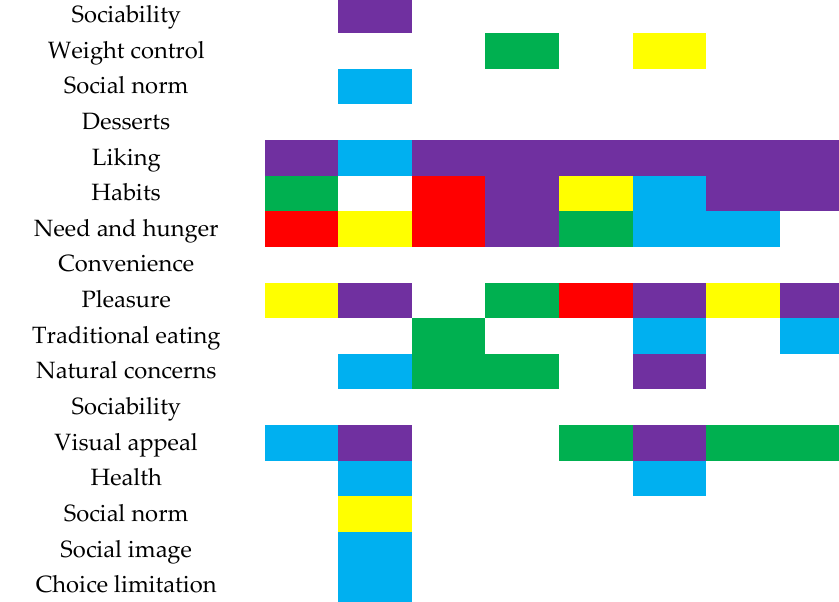
Figure 1. ( a ) Rank of the top five motivation constructs based on percentages of “apply” responses for RATA ( A ) and RATING ( C ) survey formats within each food group for Brazil, Spain, and the USA. Additionally, the top five motivation constructs based on mean scores per country for RATA ( B ) and RATING ( D ) within each food group for Brazil, Spain, and the USA are included. Rank color codes for the top five motivation constructs: purple = first position, red = second position, yellow = third position, green = fourth position, and blue = fifth position. ( b ) Rank of the top five motivation constructs based on percentages of “apply” responses for RATA ( A ) and RATING ( C ) survey formats within each food group for China and India. Additionally, the top five motivation constructs based on mean scores per country for RATA ( B ) and RATING ( D ) within each food group for China and India are included. Rank color codes for the top five motivation constructs: purple = first position, red = second position, yellow = third position, green = fourth position, and blue = fifth position.